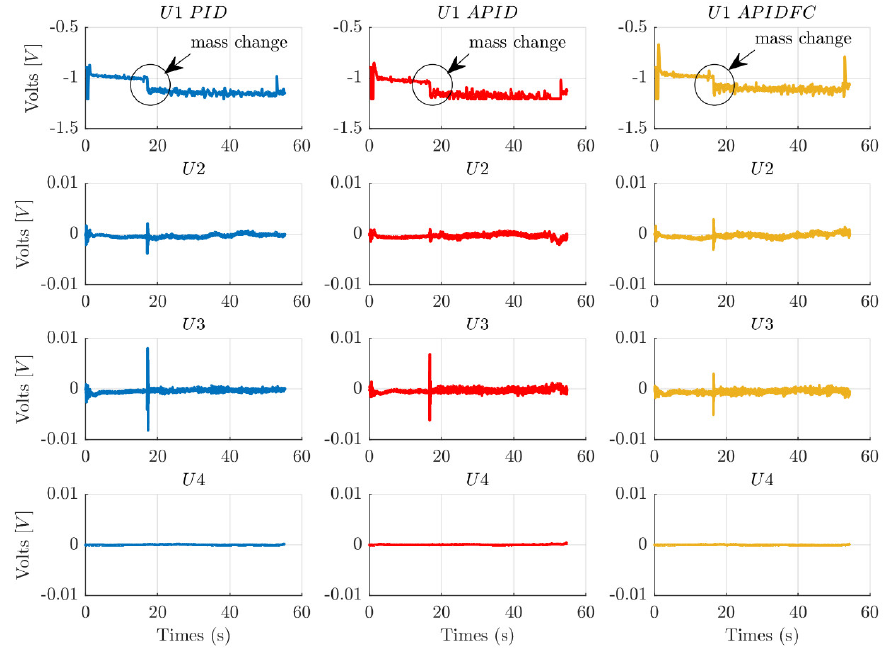
Figure 21. Motors rotation comparison from the experiment.